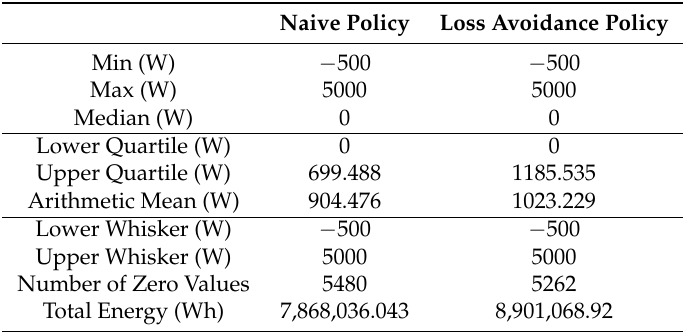
Table 7. Obtained statistical values of Figure